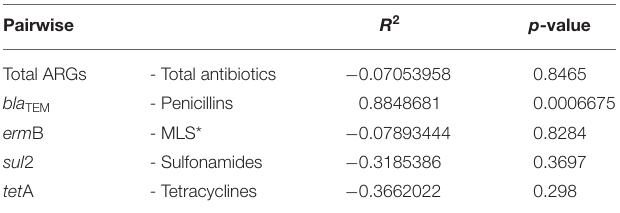
TABLE 3 | Pearson’s correlation between ARGs and the consumption of antibiotics. Pairwise R 2 p